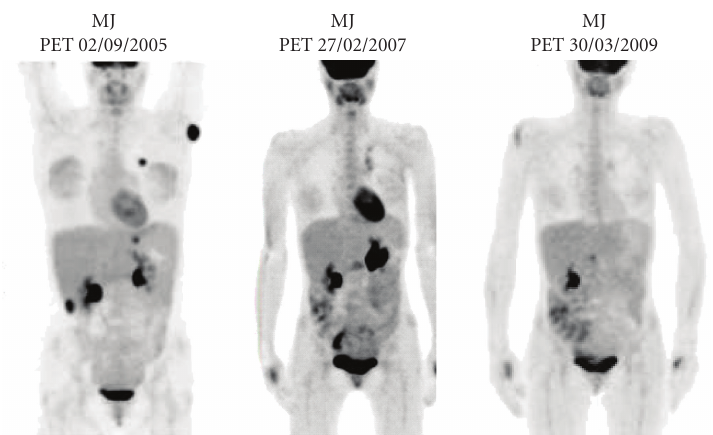
Figure 4: PET/CT scans of patient n 19 (MJ) performed in September 2005 (positive PET scan in several metastatic sites), February 2007, and March 2009 (negative PET scan for metasteses). During this period the patient underwent palliative surgery for symptomatic disease (e.g., hematuria due to renal metasteses) or to collect ATL for vaccination that started in February 2005 and terminated in June 2008 because the ATL was finished. Radiosurgery (Gamma Knife) was carried out on a small brain lesion in January 2008. The patient is still in CR (negative PET scan May 2010).